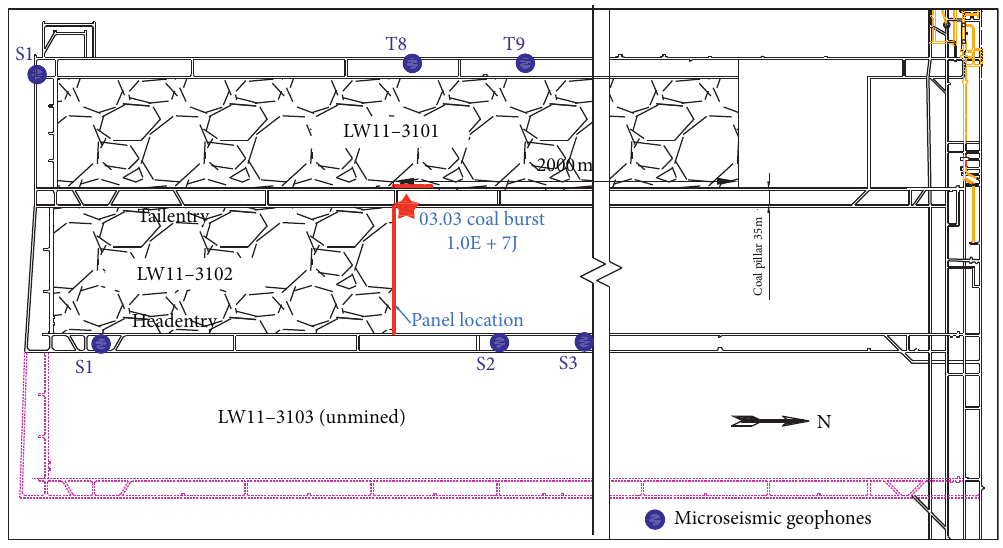
Figure 4: Layout of the LW11-3102